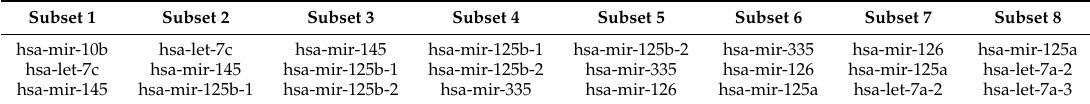
Table 4. Subset Selection of Ranked miRNA.